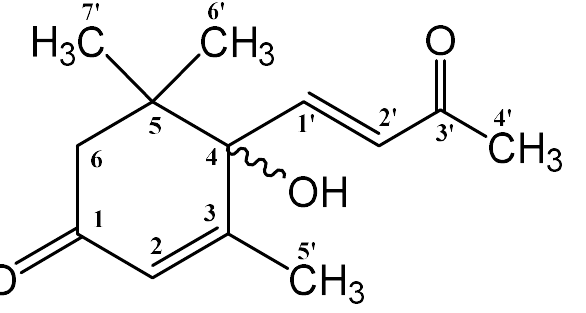
Figure 5. Structure of dehydrovomifoliol obtained from the results of the analysis of NMR and mass spectra.